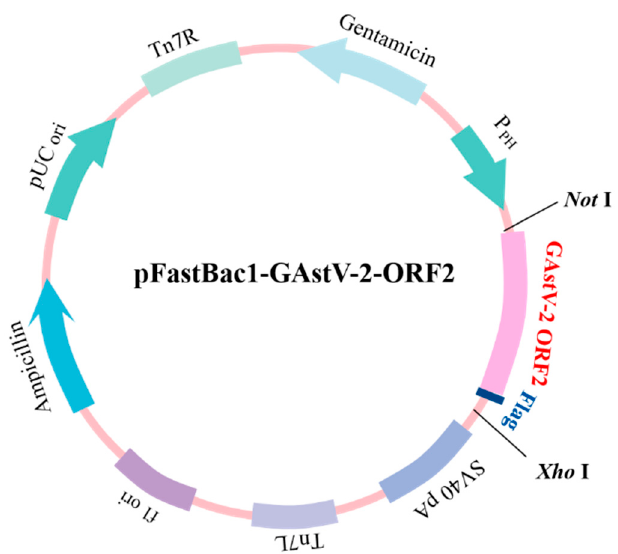
Figure 1. Schematic diagram of pFastBac1 vector construction. The GAstV-2 ORF2 gen and Flag-tag were inserted into the multiple cloning sites between the Not I and Xho I restriction sites downstream of the P PH of the pFastBac1